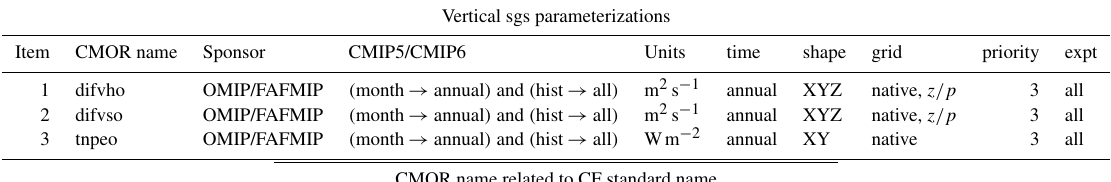
Table M1. This table summarizes diagnostics that support the study of vertical/dianeutral subgrid-scale (SGS) parameterizations. The col- umn indicating the experiment for saving the diagnostics generally says “all”, in which case we recommend the diagnostic be saved for CMIP6 experiments in which there is an ocean model component, including the DECK, historical simulations, FAFMIP, DAMIP, DCPP, ScenarioMIP, and C4MIP, as well as the ocean/sea-ice OMIP simulations. We ask only for annual means from these fields, rather than the monthly means requested for most other diagnostics. Additionally, this table has been reduced from the 12 fields requested in CMIP5 to the 3 requested here. Furthermore, the field tnpeo was requested as a three-dimensional field in CMIP5, whereas for CMIP6 it is requested as a depth-integrated two-dimensional field. The lower sub-table lists the CMOR names and the corresponding CF standard names. Vertical sgs